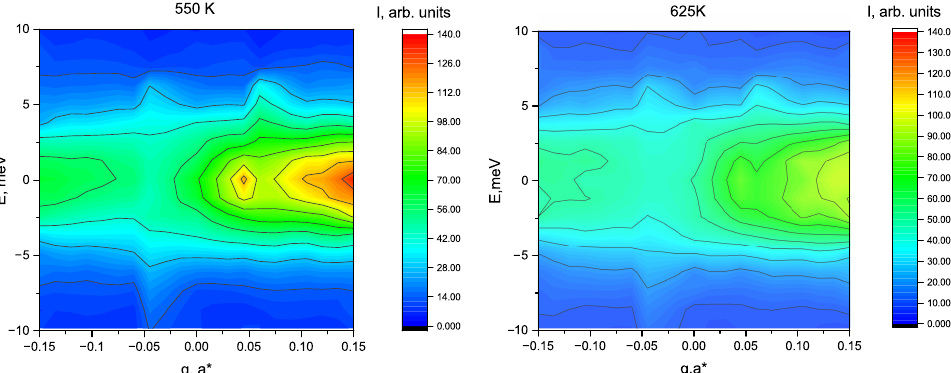
Figure 1. Two-dimensional plots of the X-ray inelastic spectra at 625 K and 550 K. q—is the deviation from the M-point and E—energy transfer in